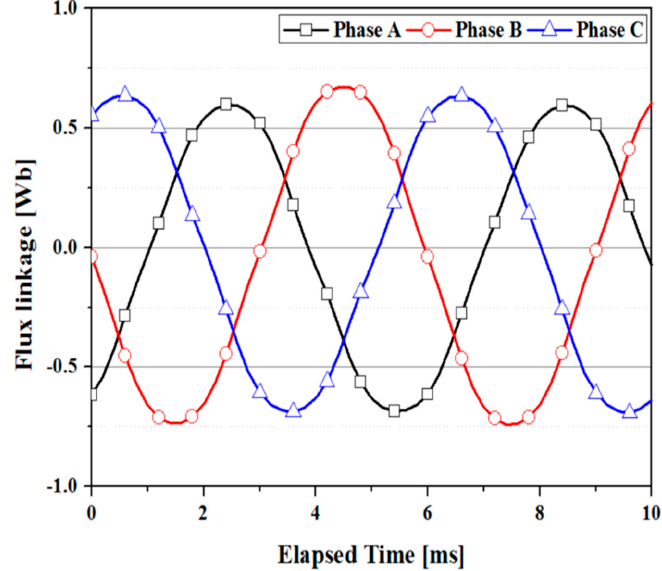
Figure 14. Flux linkage due only to the NI HTS field coil.